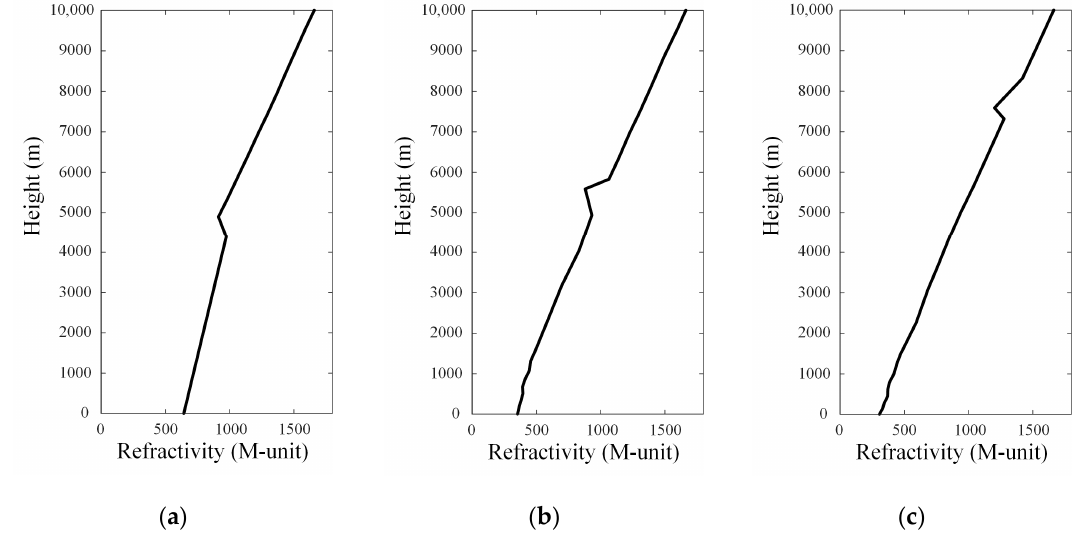
Figure 2. Modified refractive indices of the elevated duct atmospheres according to the altitude at the Heuksando meteorological observatory in Korea: ( a ) 4 September 2015; ( b ) 5 June 2015; ( c ) 10 December 2015.